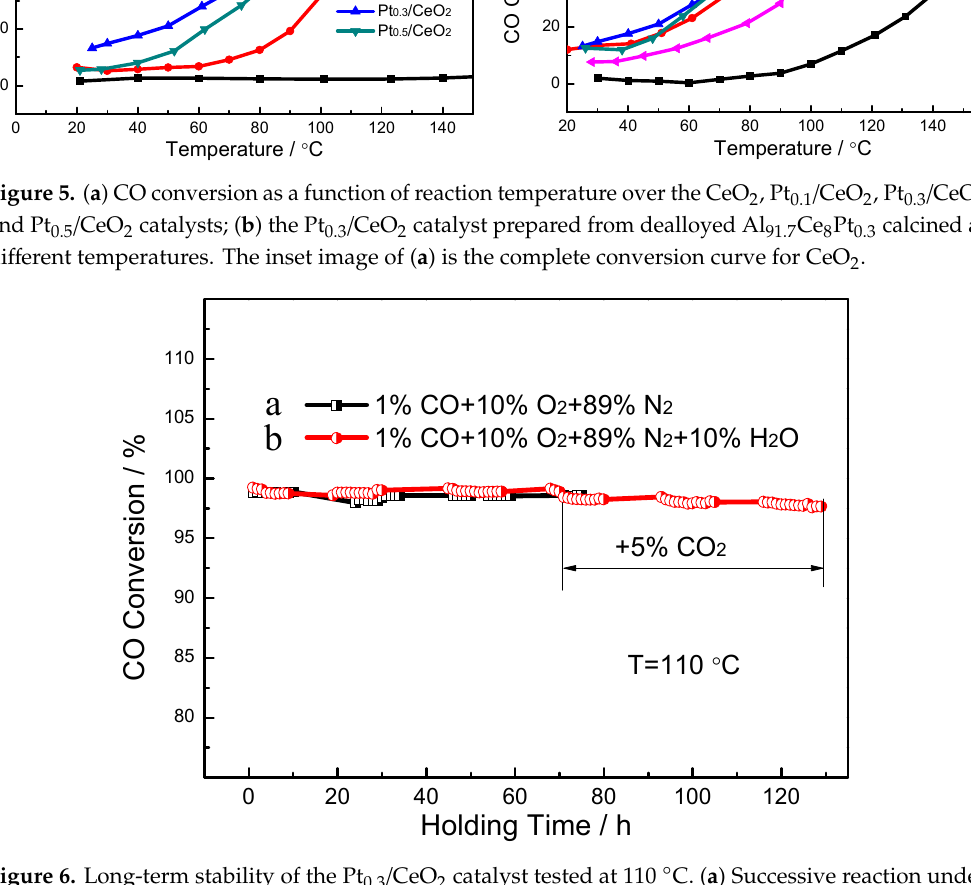
Figure 6. Long-term stability of the Pt 0.3 / CeO 2 catalyst tested at 110 ◦ C. ( a ) Successive reaction under a mixed composition of 1% CO, 10% O 2 and 89% N 2 for 75 h; ( b ) Successive reaction under mixed composition of 1% CO, 10% O 2 , 79% N 2 and 10% H 2 O for 130 h, with addition of 5% CO 2 after reaction for 70